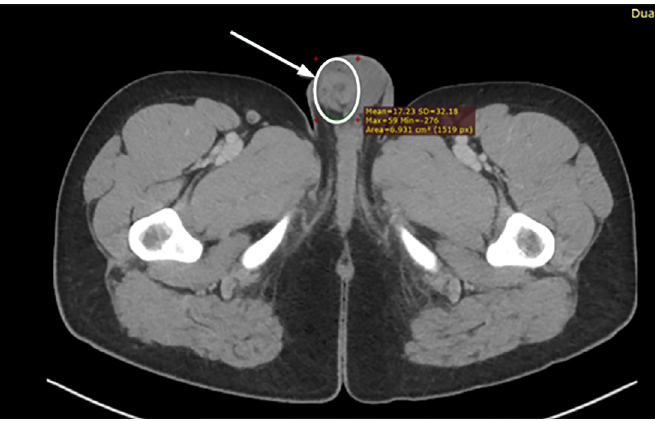
Image 1. Axial computed tomography of the abdomen and pelvis showing “whirl” sign in the right scrotum at the inferior periphery of the image suggestive of testicular torsion. The white arrow and circle highlight this